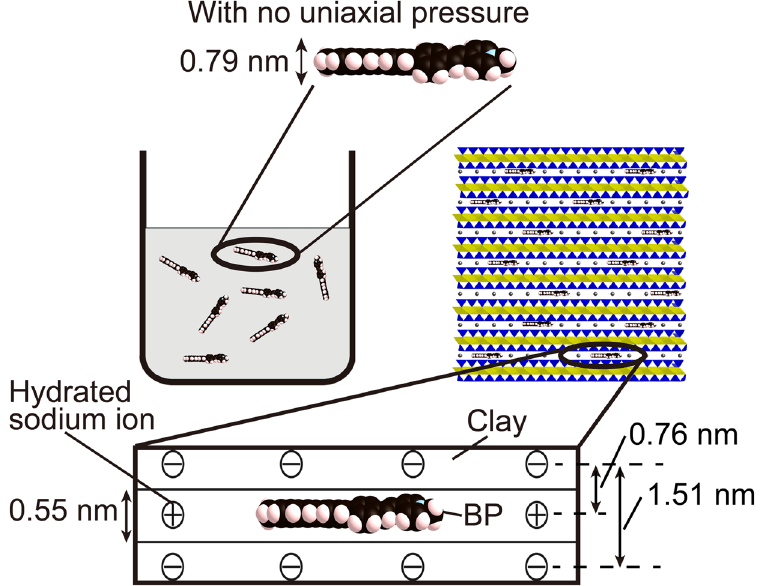
Figure 4. Schematic representation of molecular confinement of BP in solution and in a hybrid film fabricated at 27% CEC. Sodium ions and anion sites in the smectite are indicated by circles that contain plus and minus signs,